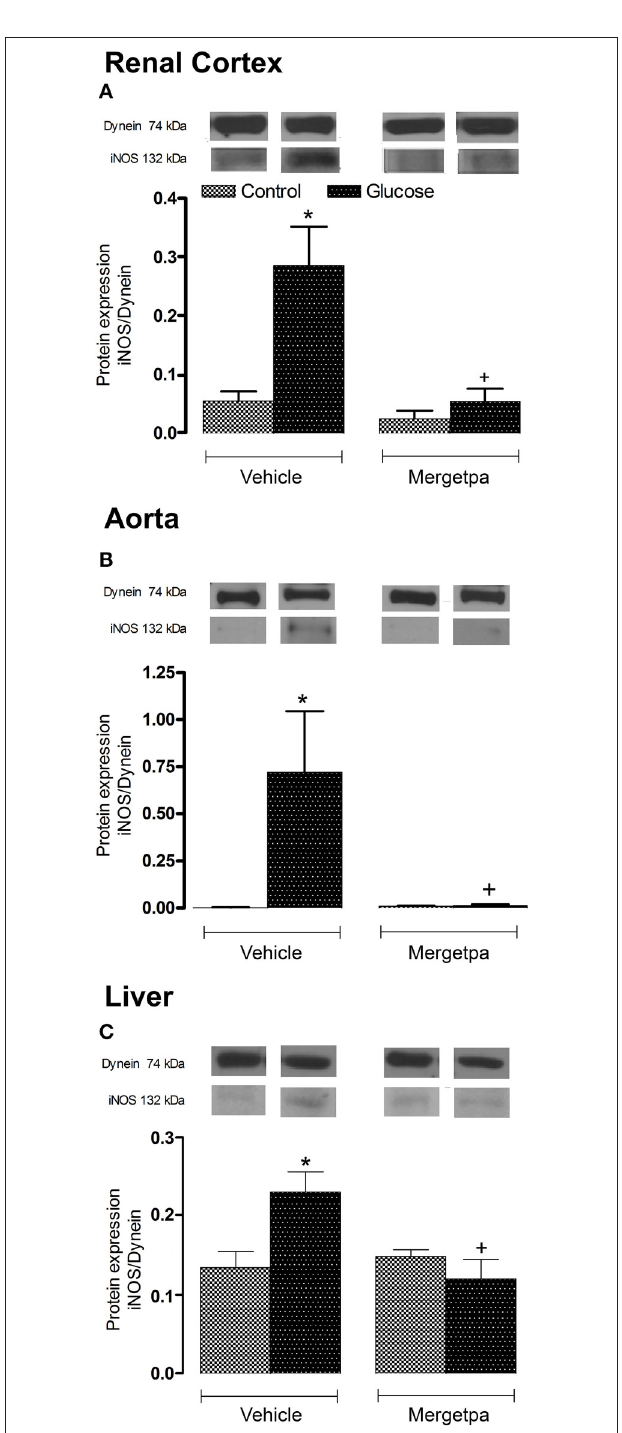
FIGURE 6 | Treatment effect on iNOS expression. Effect of s.c. administered Mergetpa (1 mg.kg − 1 twice daily) for 7 days on iNOS expression in (A) renal cortex, (B) thoracic aorta, and (C) liver. The expression of iNOS was measured at the protein level by western blot and dynein was the loading control. Data are mean ± SEM obtained from six rats per group. * P < 0.05 compared with control + vehicle; + P < 0.05 compared with glucose + vehicle. Data in vehicle treated rats are from a previous study (Haddad and Couture, 2016) but performed